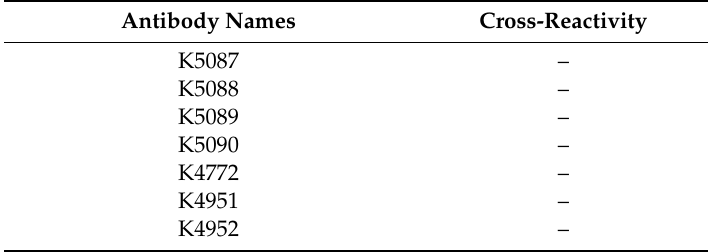
Table 3. ELISA test on the ASM of A. hians . The matrix was tested against 17 polyclonal antibodies raised against diverse mollusc shell fractions or purified proteins (see Supplementary Table S1). XXX = > 80% cross-reactivity; XX = 50–80% cross-reactivity; – = < 10% cross-reactivity.